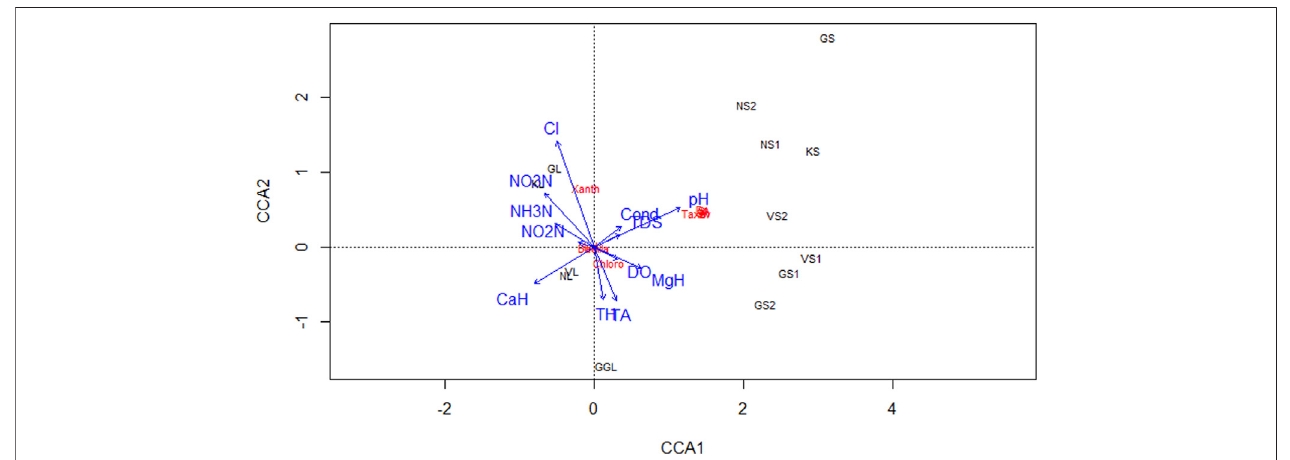
FIGURE 8 | Canonical correspondence analysis (CCA) biplot, between physicochemical parameters and algal composition at HAL sites.